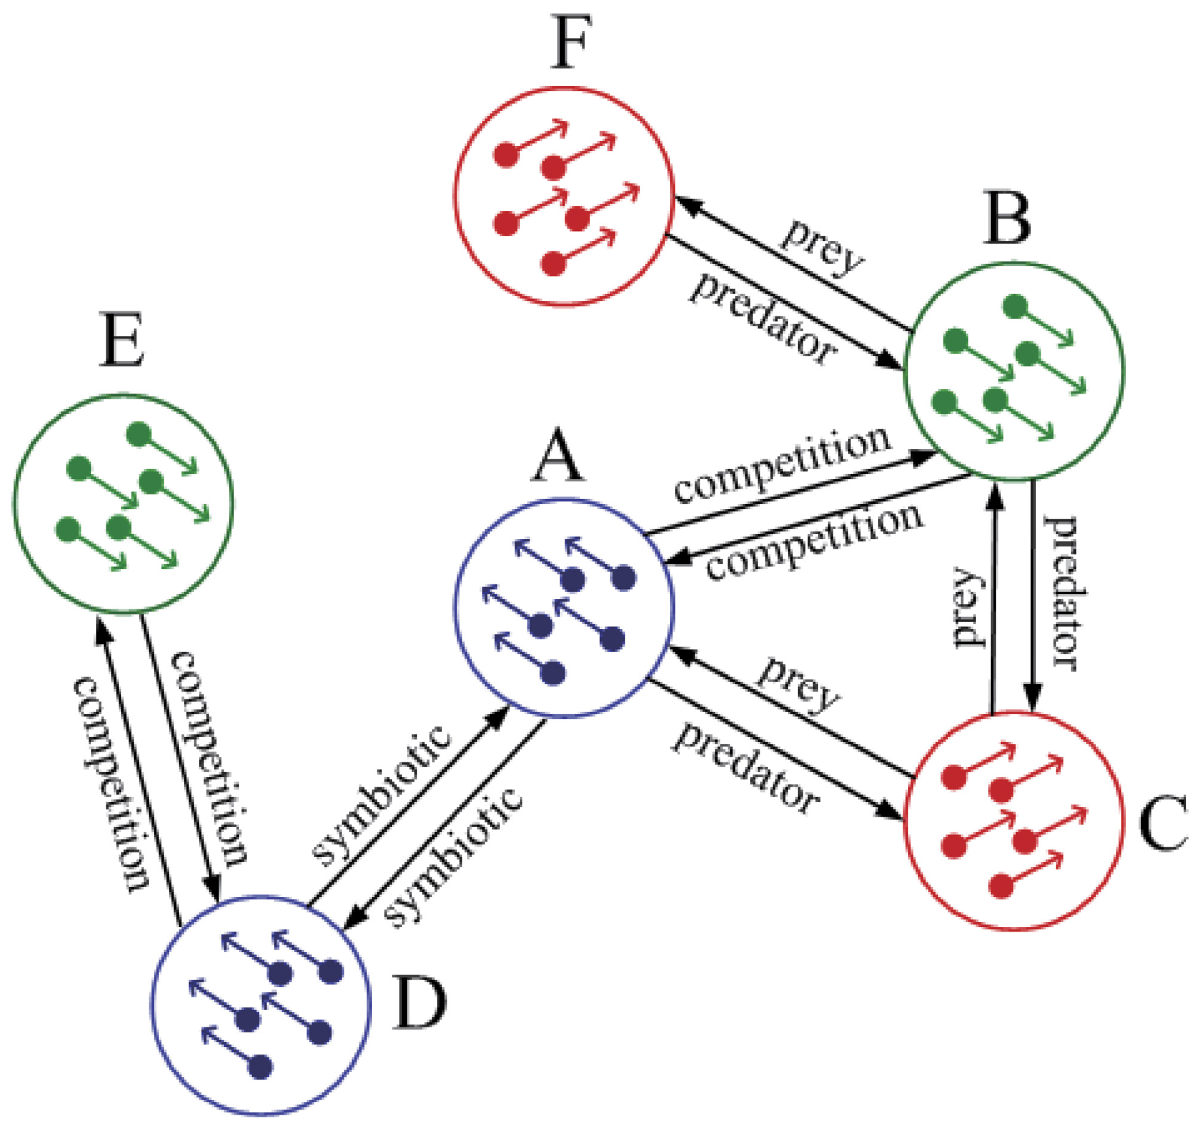
Fig 2. Illustrate a simple network of self-propelled agent systems. This system is composed of 6 SPA subsystems, showing that: (i) if two sub-systems are connected by the symbiotic relationship, the two subsystems tend to synchronize to the same direction (for example A and D); (ii) if two subsystems are connected by the competitive relationship, the two subsystem tend to synchronize with opposite directions (for example A and B); (iii) if two subsystems are connected by the predator-prey relationship, the two subsystem tend to synchronize with different directions (for example A and C).